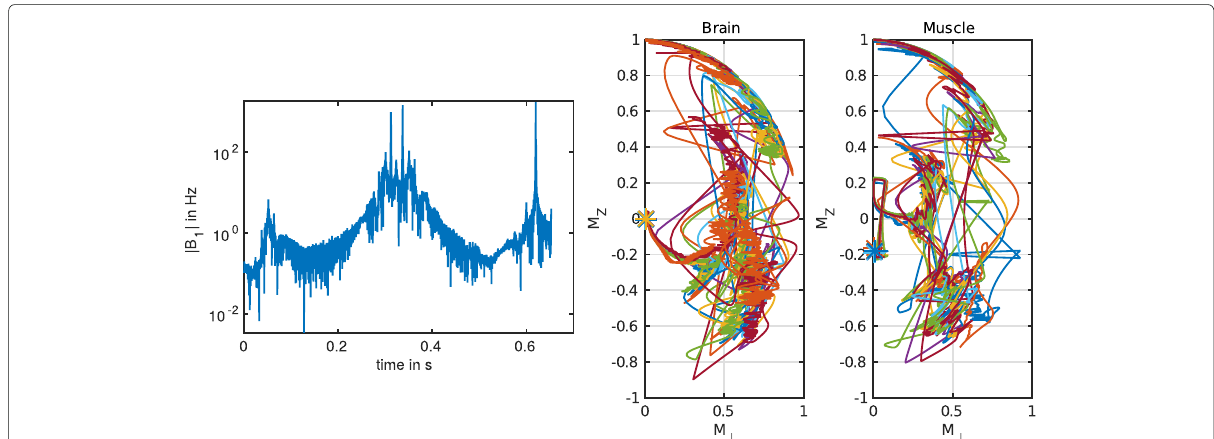
Fig. 6 (Color online) Left: Amplitude of the optimal RF pulse in a log scale graph. Right: Magnetization trajectories of the brain and muscle tissues. Each trajectory represents a specific resonance frequency offset in the interval [-400 Hz, 400 Hz]. A sampling rate of 40 Hz is considered to discretize this interval. Star markers represent the ending point (at time t = t f ) of each trajectory